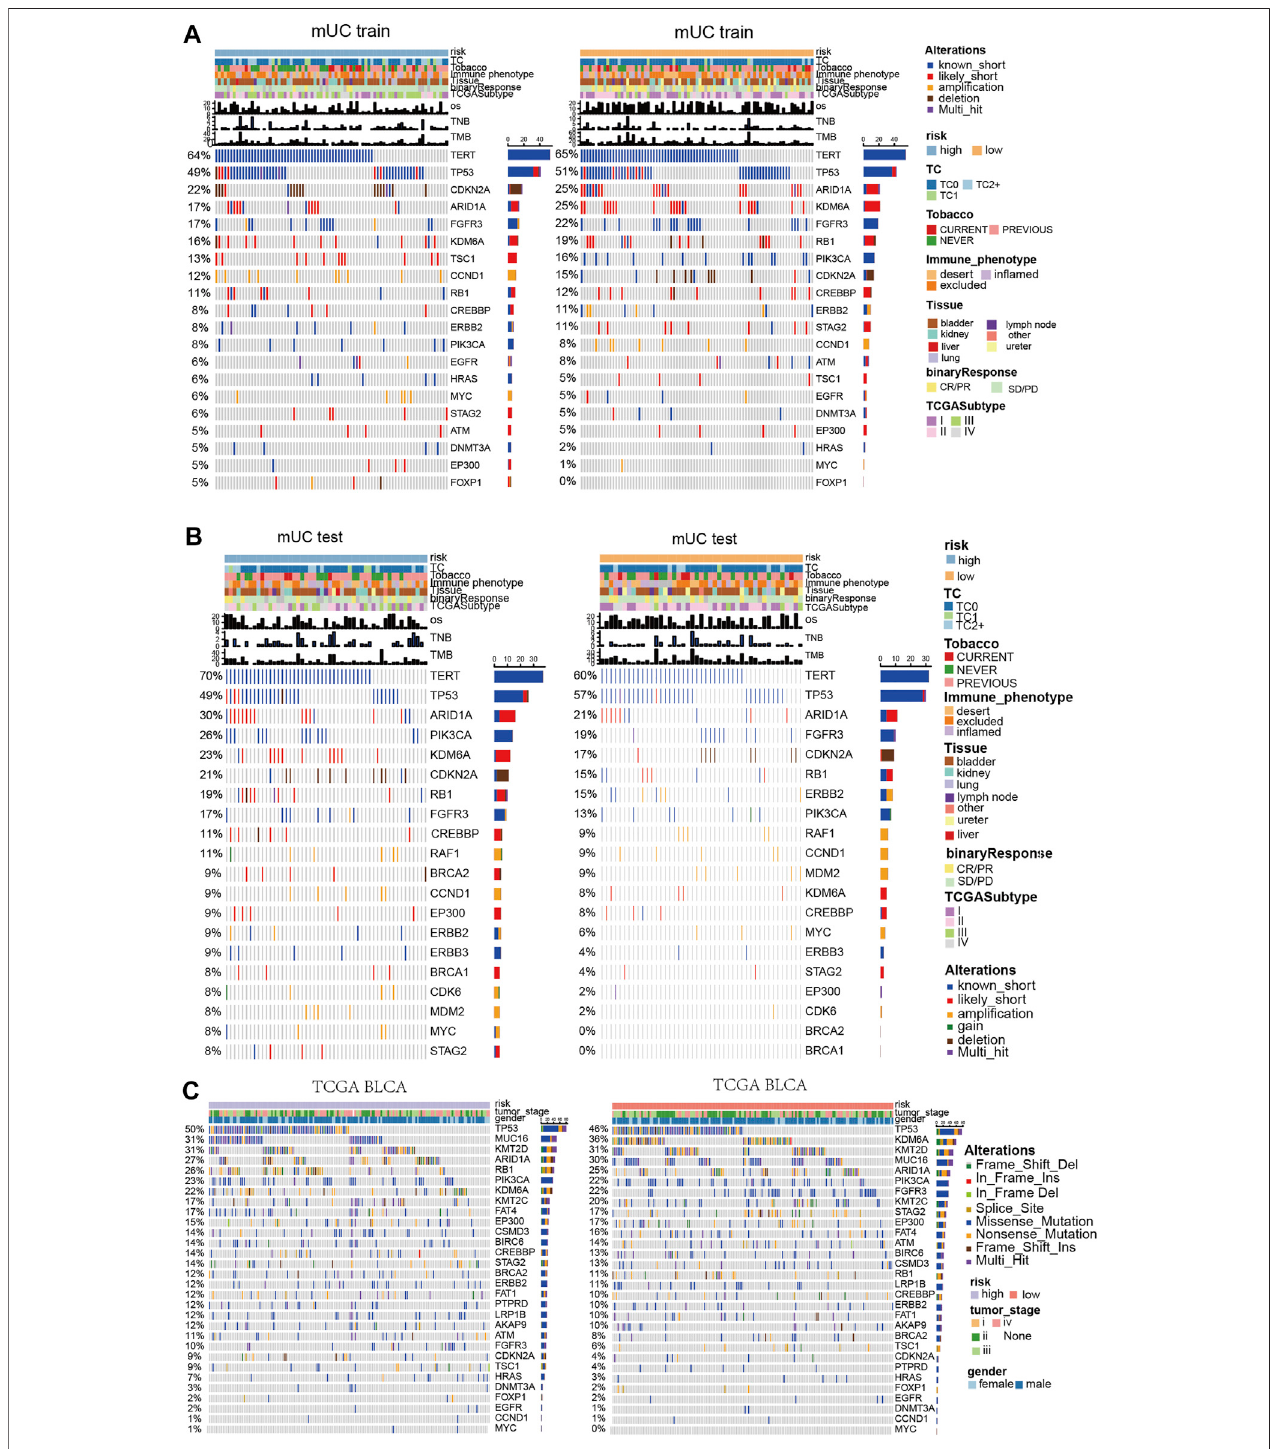
FIGURE 4 | Panoramic view of metastatic urothelial carcinoma and TCGA BLCA mutation gene, gene co mutation and mutual exclusion analysis. (A) Panoramic view of the top20 driving gene mutation of the MUC training set. (B) Panorama of top20 driving gene mutation of the MUC testing set. (C) Panorama of top driving gene mutation in the TCGA BLCA cohort.